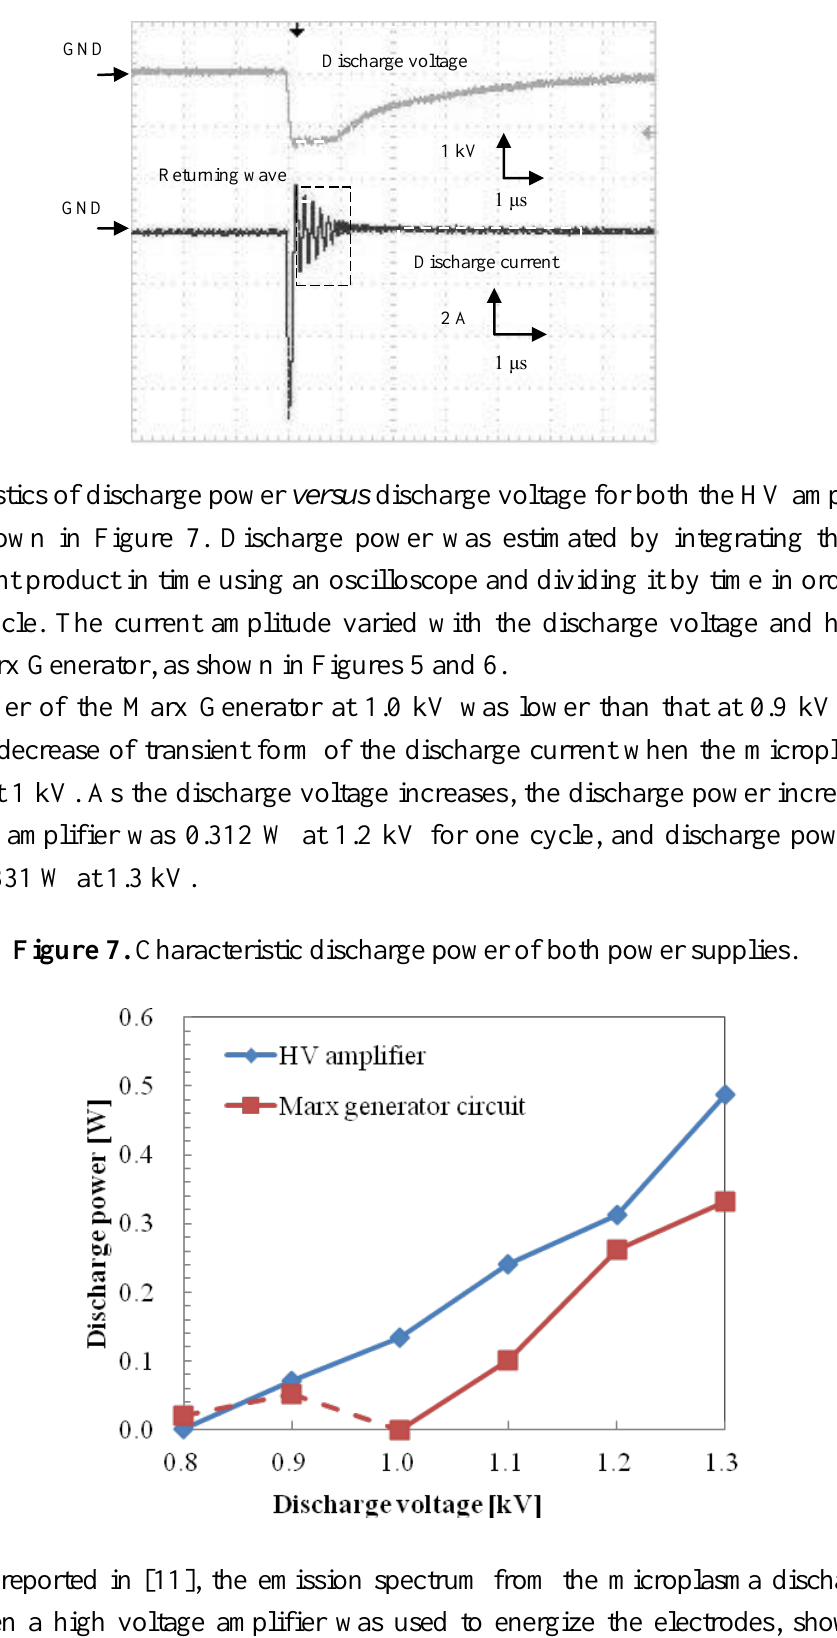
Figure 6. Discharge voltage and corresponding discharge current by a Marx Generator.